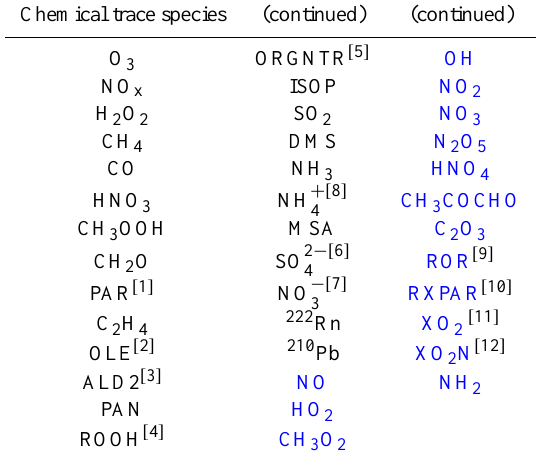
Table 2. The chemical trace species which are included in the tropospheric chemistry version of TM5. The definitions of the lumped species, aerosols and operators are: [1] paraffinic carbon atoms, [2] olefinic carbon bonds, [3] CH 3 CHO and higher aldehy- des, [4] higher organic peroxides, [5] alkyl nitrates, [6] sulphate aerosol, [7] nitrate aerosol, [8] ammonium aerosol, [9] organic ethers, [10] PAR budget corrector, [11] NO to NO 2 operator and [12] NO to alkyl nitrate operator. The O( 1 D) species is not specif- ically included in the scheme. The chemical trace species that are not transported are shown in